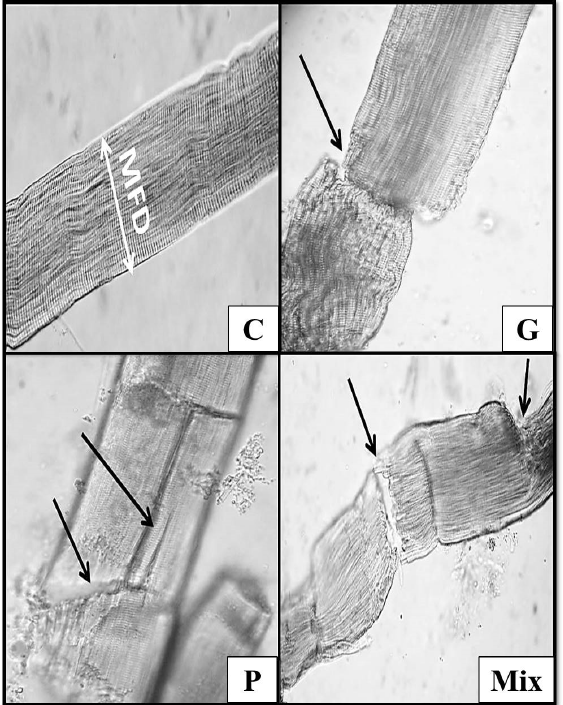
Figure 2. Light micrograph of none-stained camel semitendinosus muscle samples ( × 40). C: control; G: ginger extract; P: papain-enzyme powder; Mix: a mixture of ginger and papain. White arrow points to MFD (muscle-fiber diameter); black arrows point to fragmentation in muscle fibers.